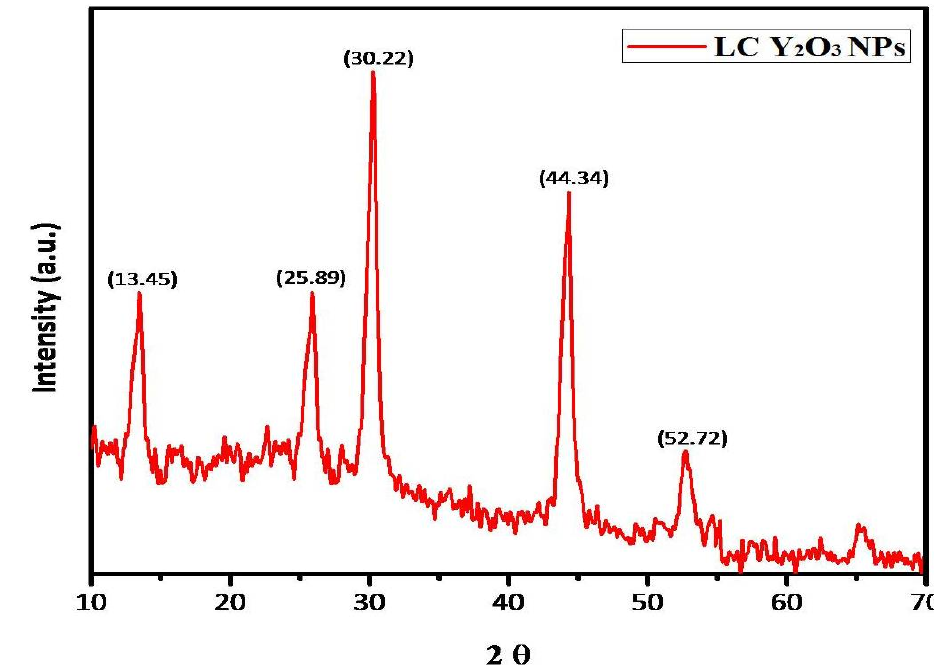
Figure 3. XRD pattern of green synthesized LC Y 2 O 3 NPs (JCPDS card no. 83-0927).